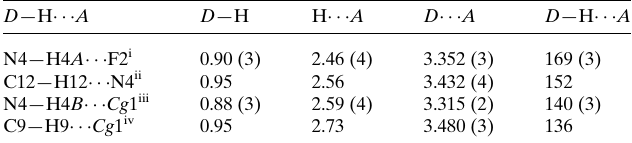
Table 1 Hydrogen-bond geometry (A˚ , (cid:2) ). Cg 1 is the centroid of the C5–C10 ring.